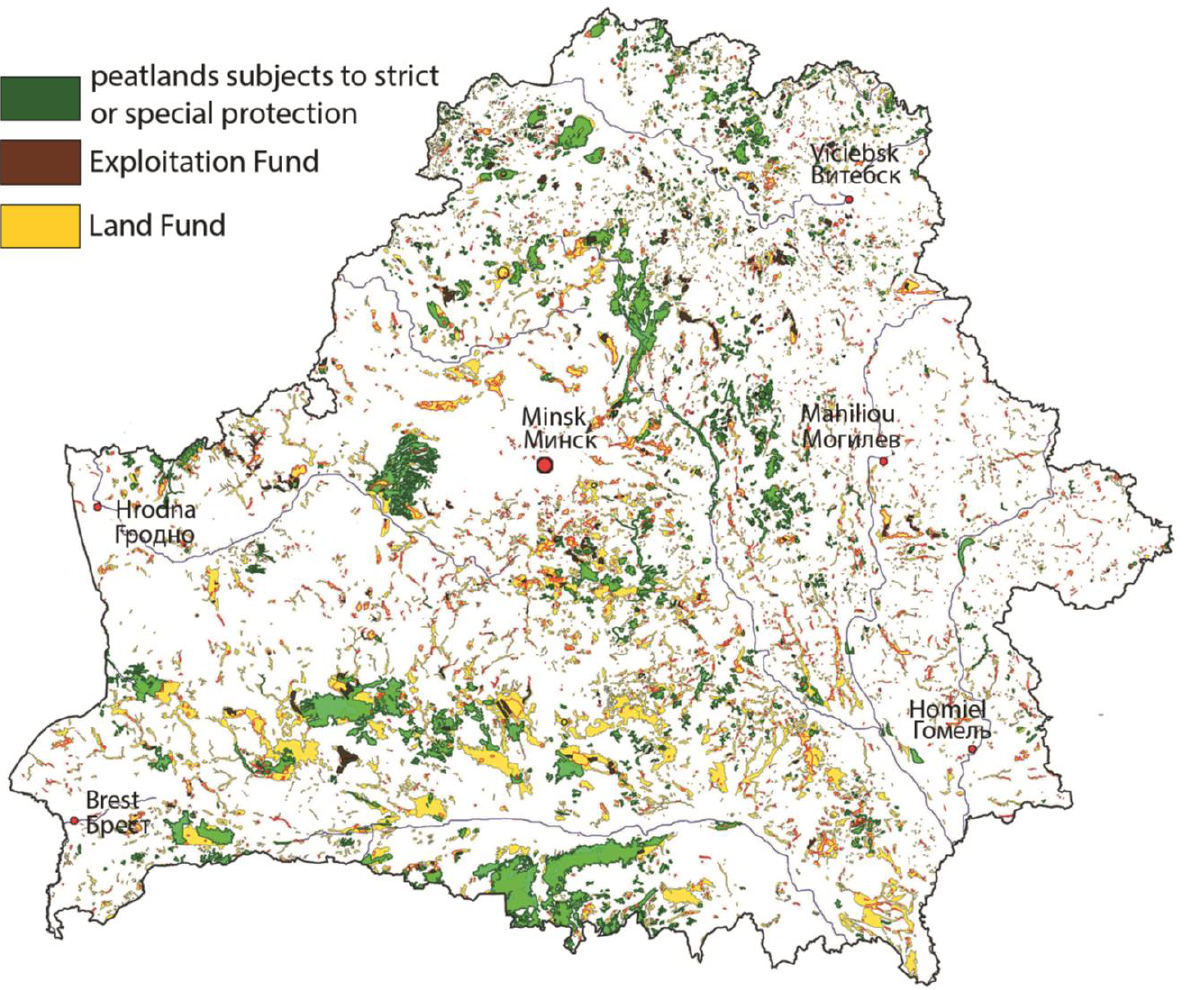
Figure 7. Map of Belarus showing the distribution of peatlands as allocated amongst the three main land funds by the ‘Scheme until 2030’, based on the principles set out in the Strategy and the descriptions of their current